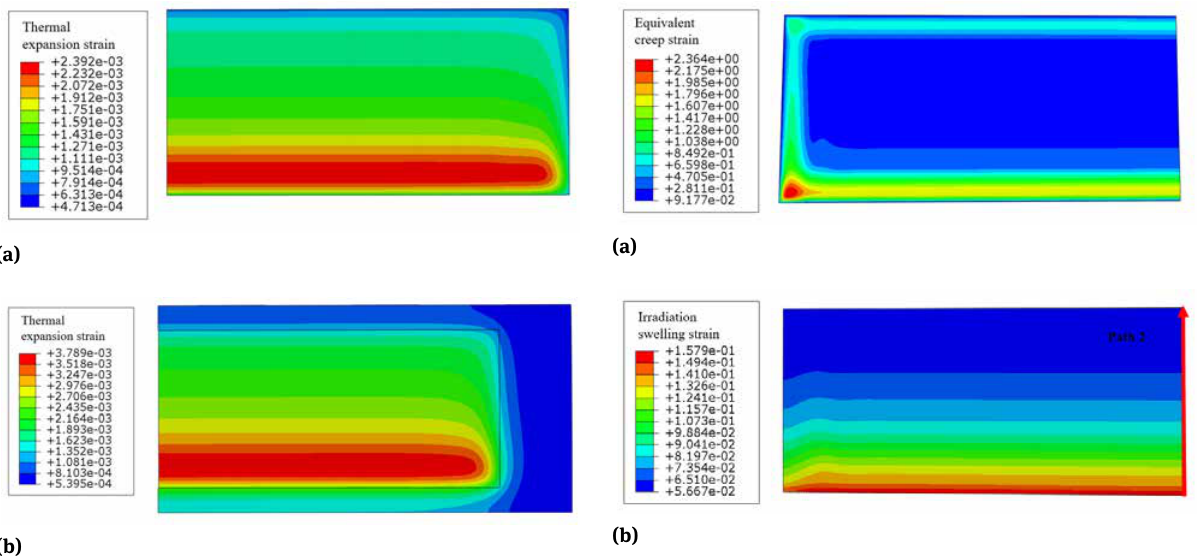
Figure 14: The contour plots of (a) equivalent creep strains and